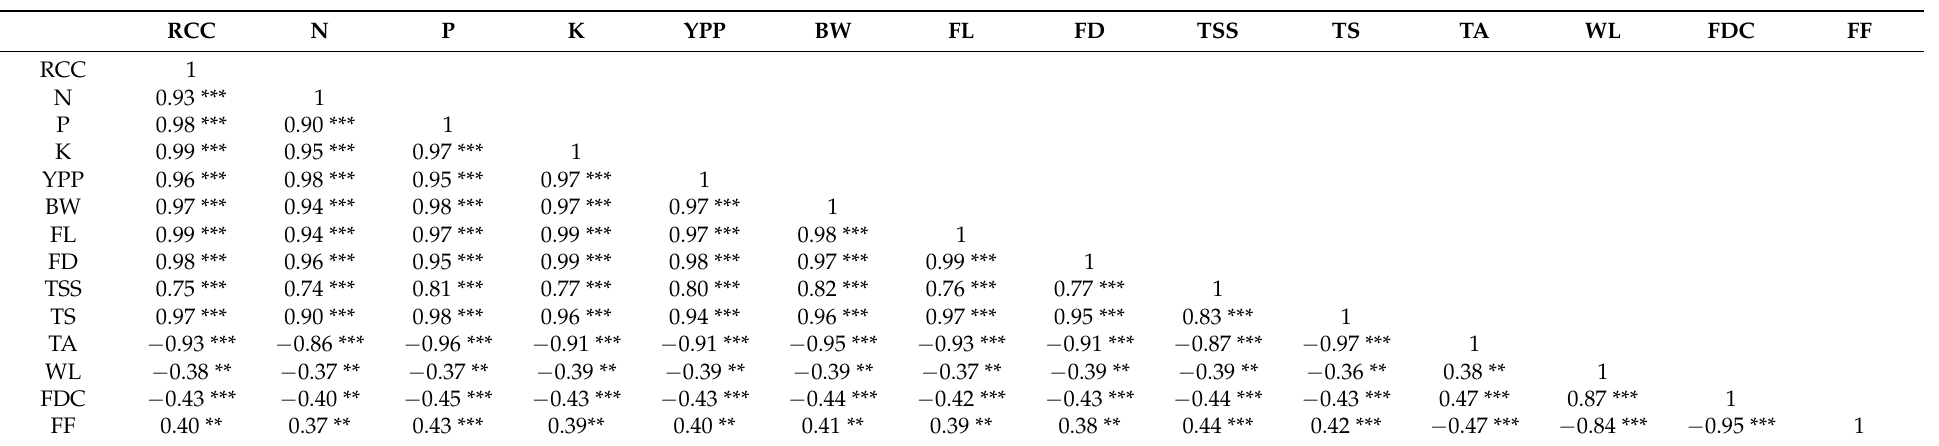
Table 8. Pearson moment correlations (r) matrix between fourteen variables recorded from date palm trees (cv. Barhi). RCC N P